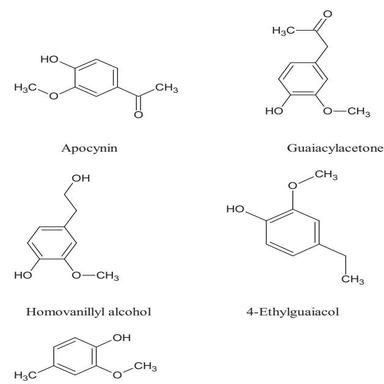
Chemical structures of apocynin, guaiacylacetone, homovanillyl alcohol, 4-ethylguaiacol, homoguaiacol molecules.